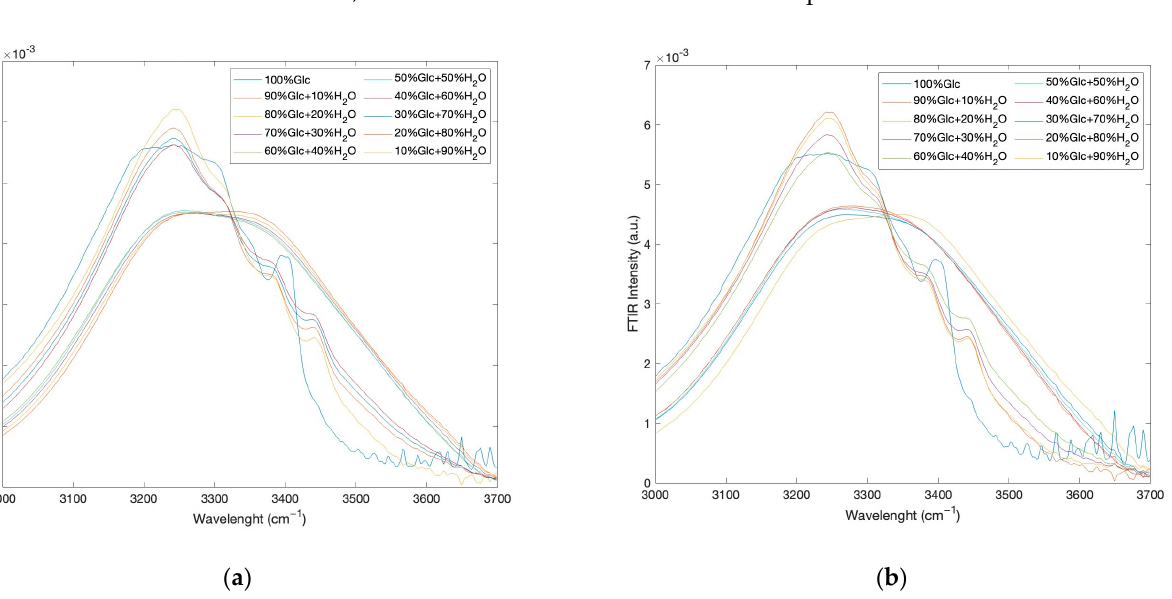
Figure 5. ( a ) Registered FTIR intramolecular OH stretching band intensities, as a function of concen- tration at the temperature value of T = 35 ◦ C; ( b ) Registered FTIR intramolecular OH stretching band intensities, as a function of concentration at the temperature value of T = 50 ◦